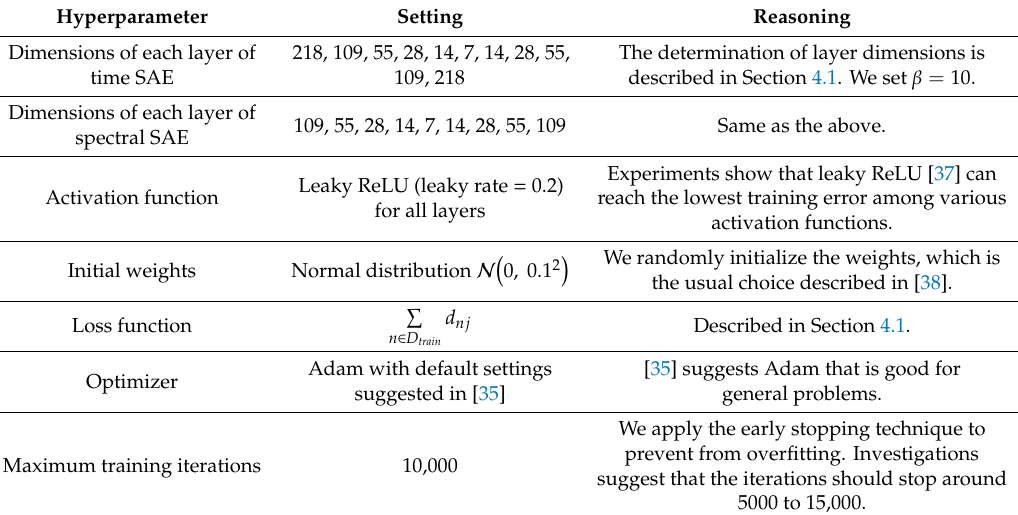
Table 5. The hyperparameter settings for the experiment in Section